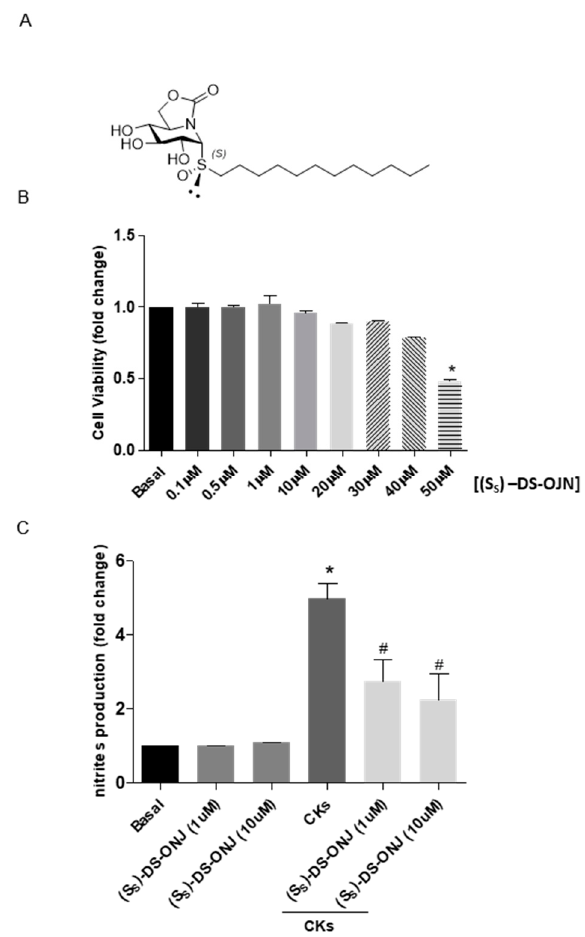
Figure 1. Anti-inflammatory effects of (S S )-DS-ONJ in CKs-stimulated MCT cells. ( A ) Chemical structure of ( S S )-DS-ONJ. ( B ) MCT cells were treated for 24 h with ( S S )-DS-ONJ (0.1–50 µ M). Viability was determined by crystal violet staining. Colorimetric quantification was performed and the results are shown as mean ± SEM (n = 3 independent experiments). ( C ) MCT cells were treated for 24 h with CKs or CKs plus ( S S )-DS-ONJ (1–10 µ M). Nitrite accumulation was analyzed and related to the basal levels. Colorimetric quantification was performed, and the results are expressed as mean ± SEM (n = 6 independent experiments). The fold change relative to the basal condition is shown; * p ≤ 0.05 vs. Basal; # p ≤ 0.05 vs. CKs (two-way ANOVA followed by Bonferroni t -test).